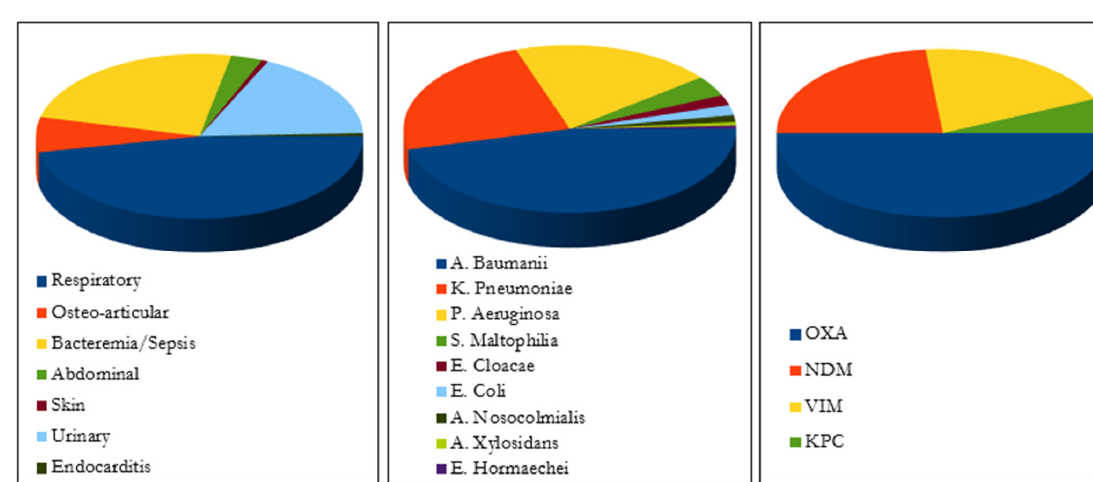
Figure 2. Type of infection, bacterial agents and carbapenemase enzymes.